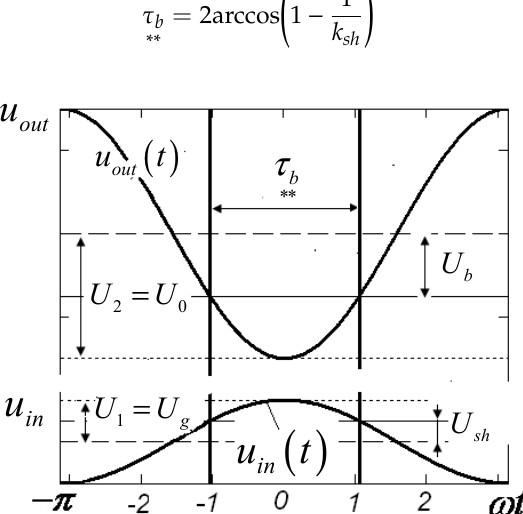
Figure 13. Schemes of formation of the bunch in the entry gap and its inhibition in the output gap of the resotrode .